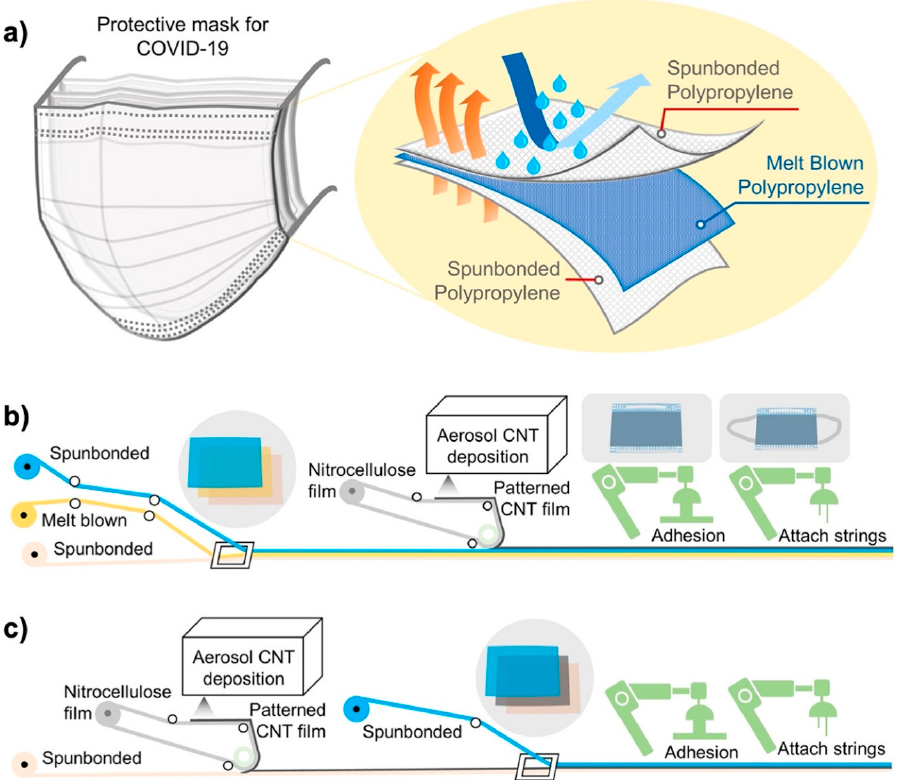
Figure 4. Illustration of ( a ) a conventional face mask with an SMS filter, ( b ) the manufacturing of SMS filters when the CNT filter is added to the process, and ( c ) the manufacturing of face masks where the CNT filter replaces the melt-blown layer. (Reproduced with permission from Ref. [50]). Soni et al. [51] also prepared a CNT mask using a single-step spray-coating technique on a melt-blown polypropylene surgical mask. The prepared mask demonstrated super- hydrophobicity and excellent self-sterilization (photothermal) performance. Under solar light, the CNT-coated mask’s virucidal effectiveness was measured to be over 99%. A the- oretical study by Patel et al. [52] on binding interactions between CNTs having different morphologies and SARS-CoV-2 revealed that CNTs possess significant binding affinities and strongly interact with the active sites of the coronavirus. The best contender for in- corporation in PPE kits to accumulate any free SARS-CoV-2 particles present in the air was determined to be an armchair-type CNT with a hollow core. Singh et al. [53] used a